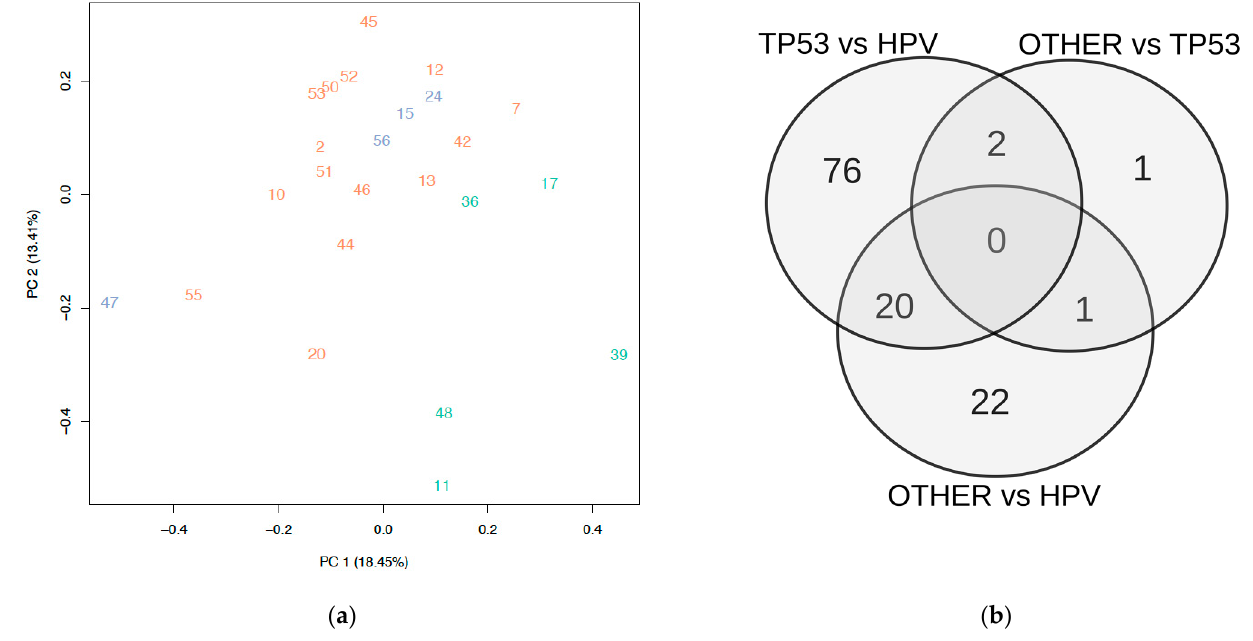
Figure 4. ( a ) Principal component analysis (PCA) of the three groups. Red: TP53mut, green: HPV+, blue: “OTHER”; ( b ) VENN diagram of the differentially expressed genes within the three subgroups; Detailed information on the underlying gene expression data and the intersections shown are provided in the supplements (Table S4).